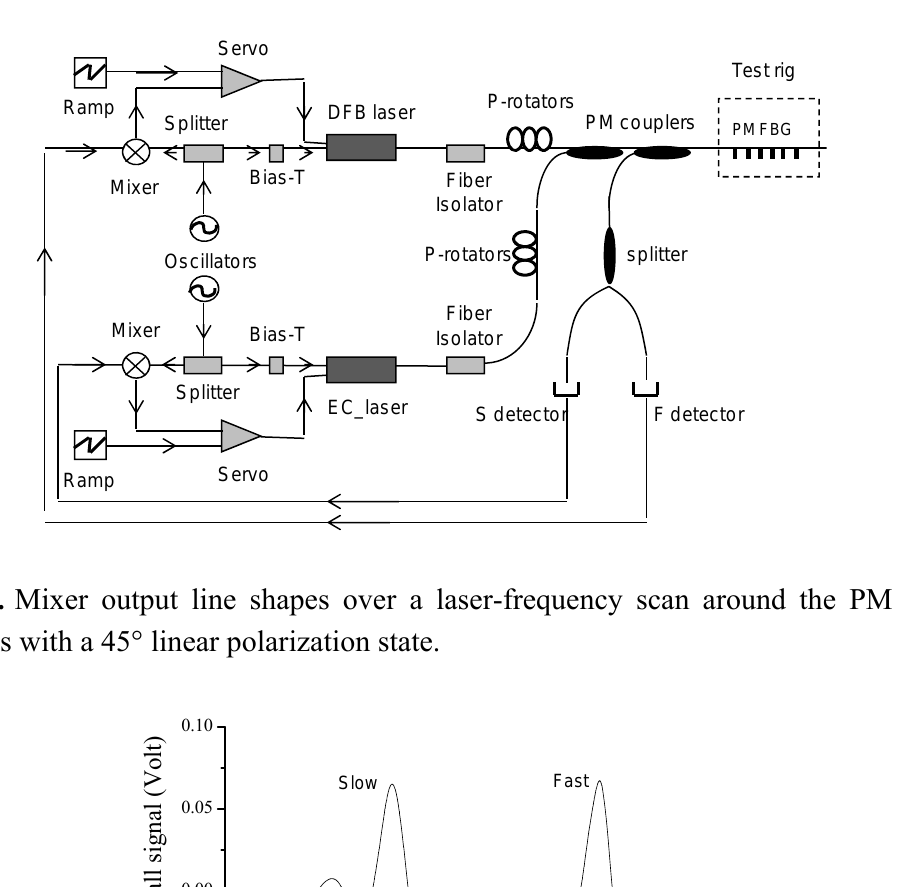
Figure 2. Experimental set-up: P-rotators: polarization rotators; splitter: polarization splitter; EC laser: extended cavity laser.